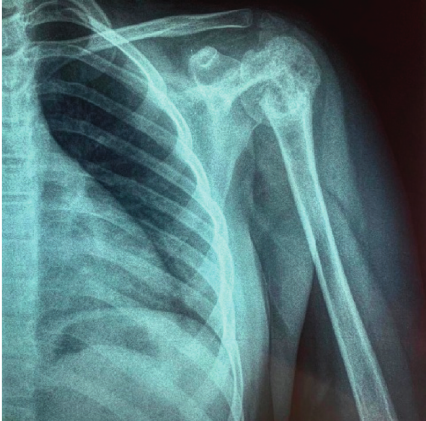
Figure 1: Plain film reveals osteolytic metastases in the left humerus.